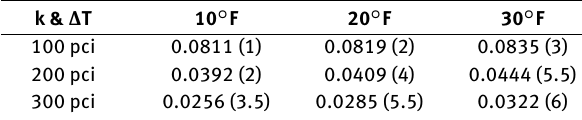
Table 4: Comparisons of deflection (inch) and its node row position k & ∆ T 10 ∘ F 20 ∘ F 30 ∘ F 100 pci 0.0811 (1) 0.0819 (2) 0.0835 (3) 200 pci 0.0392 (2) 0.0409 (4) 0.0444 (5.5) 300 pci 0.0256 (3.5) 0.0285 (5.5) 0.0322